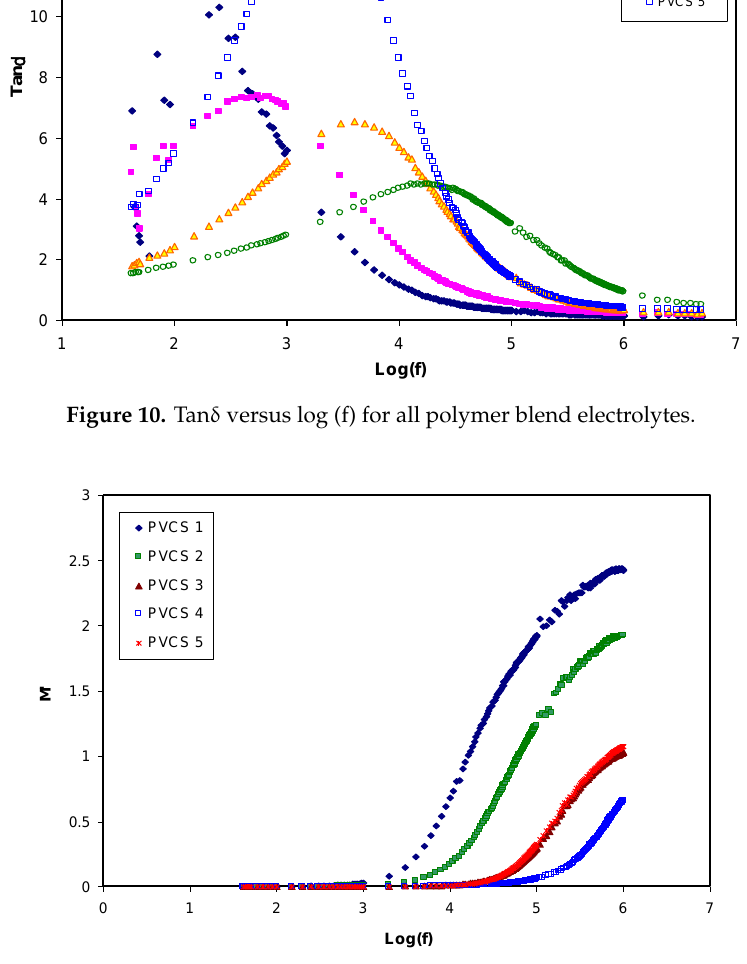
Figure 12. Imaginary part of electric modulus versus log (f) for all polymer blend electrolytes.